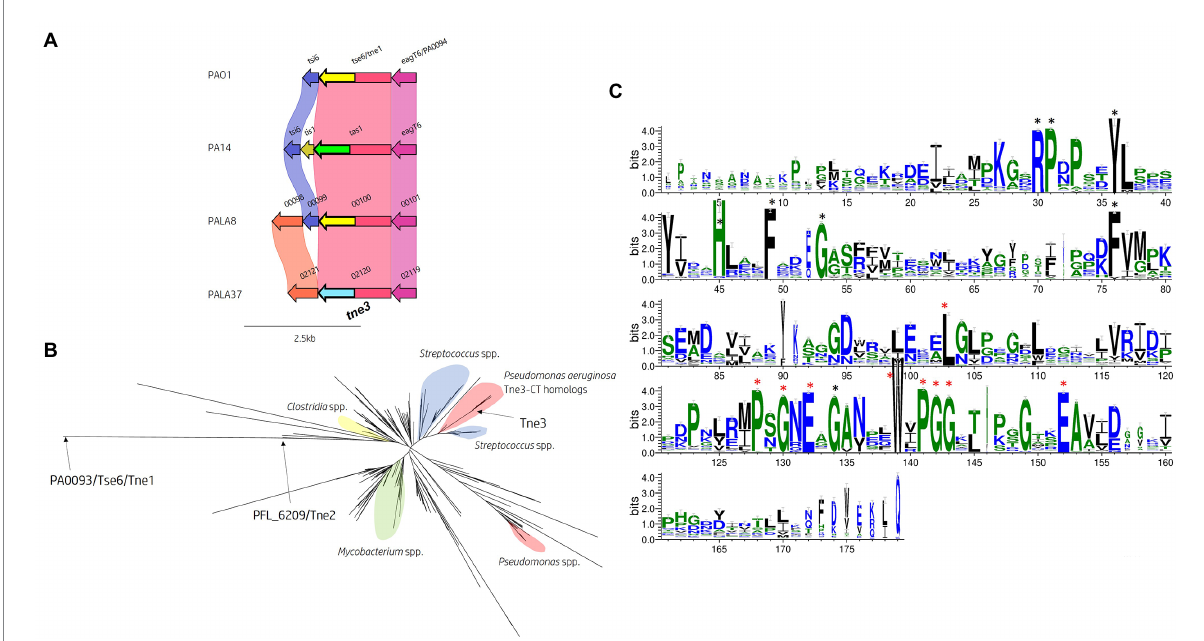
FIGURE 11 In silico analysis of the tse6 genomic loci reveals diversity across multiple P. aeruginosa strains and identifies tne3 as encoding a different effector class. (A) Comparative visualisation of the Tse6 effector loci in PAO1, PA14 and clinical isolates PALA8 and PALA37 shows variation in the immunity genes. Variation in the C-terminal region of Tse6, Tas1 PALA8_00100 and PALA37_02120 is indicated by the C-terminal coloured arrows but masked in the coloured connecting bands of the homology mapping due to the overall homology of the proteins. C-terminal toxic domains of tse6/tne1 homologs are yellow, tas1 homologs are green, and tne3 homologs are blue. (B) Maximum likelihood phylogenetic tree derived from Tne3 homologous sequences identified from a JackHMMER search against Tne1 (PA0093/Tse6 PAO1 ) from PAO1 and Tne2 (PFL_6209) from P. protegens Pf-5 using MEGAX. Select clades have been highlighted due to consensus clustering blue = Streptococcus spp., yellow = Clostridium spp., red = Pseudomonas spp., and green = Mycobacterium spp. Tne1, 2, and 3 are labelled with arrows. Phylogenetic analysis was conducted in MEGAX using the WAG model, G + I (n = 5), bootstrap n = 500, “partial deletion (95%),” and NNI ML heuristic model parameters. The tree was visualised using the iTOL (v6) webserver (Letunic and Bork, 2021). (C) WebLogo3 visualisation of the most frequent amino acids present in Tne3 homologs. Conserved residues are labelled with a black star and residues found in 90-100% of sequences aligned are labelled with a red star and are likely important for peptidase activity. Visualised using WebLogo3 (Crooks et al.,